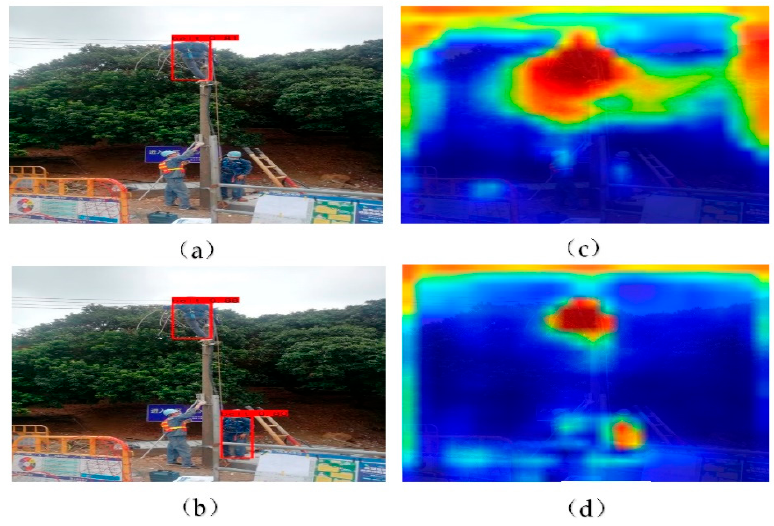
Figure 7. Results of the original network’s missed samples: ( a ) prediction of YOLOv4-tiny; ( b ) prediction of YOLO-DFAN; ( c ) heatmap of YOLOv4-tiny; ( d ) heatmap of YOLO-DFAN.